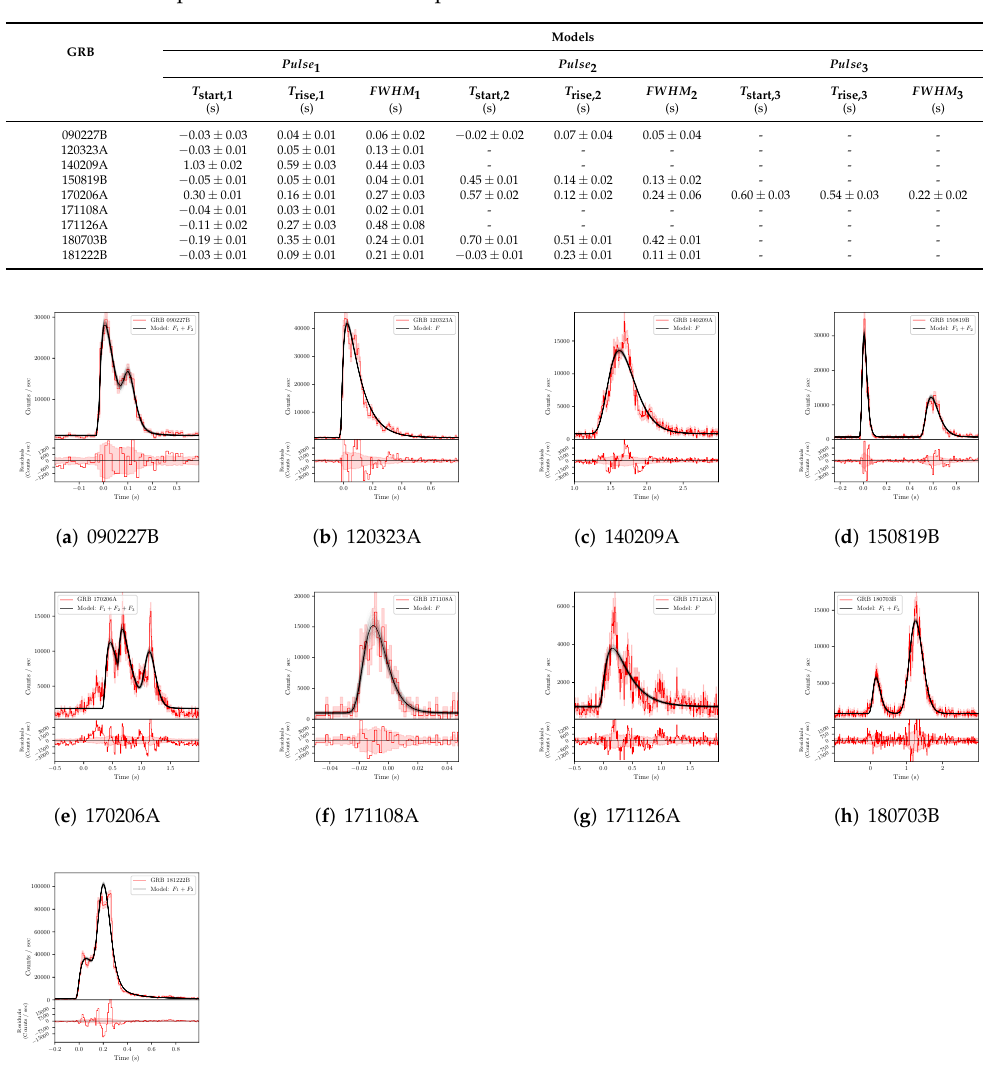
Table 2. Derived parameters of GRB FRED pulses .